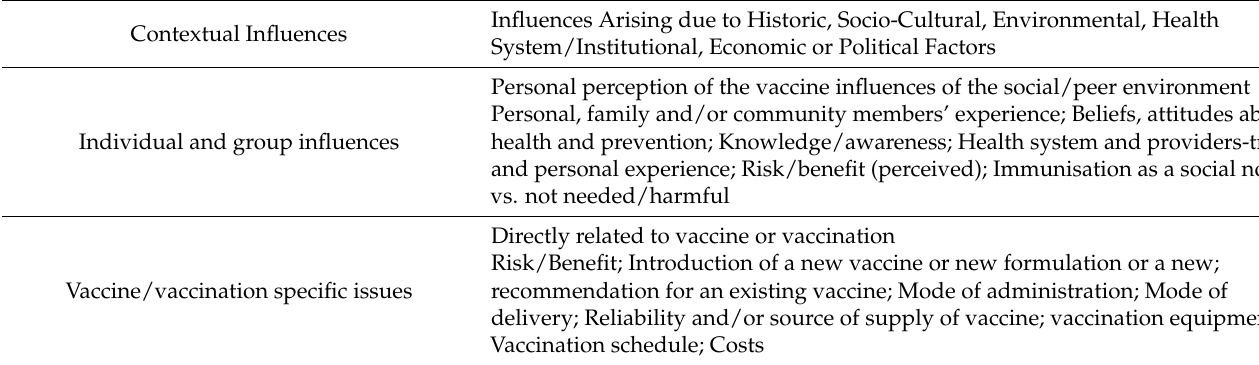
Table 1. Vaccine confidence measurement